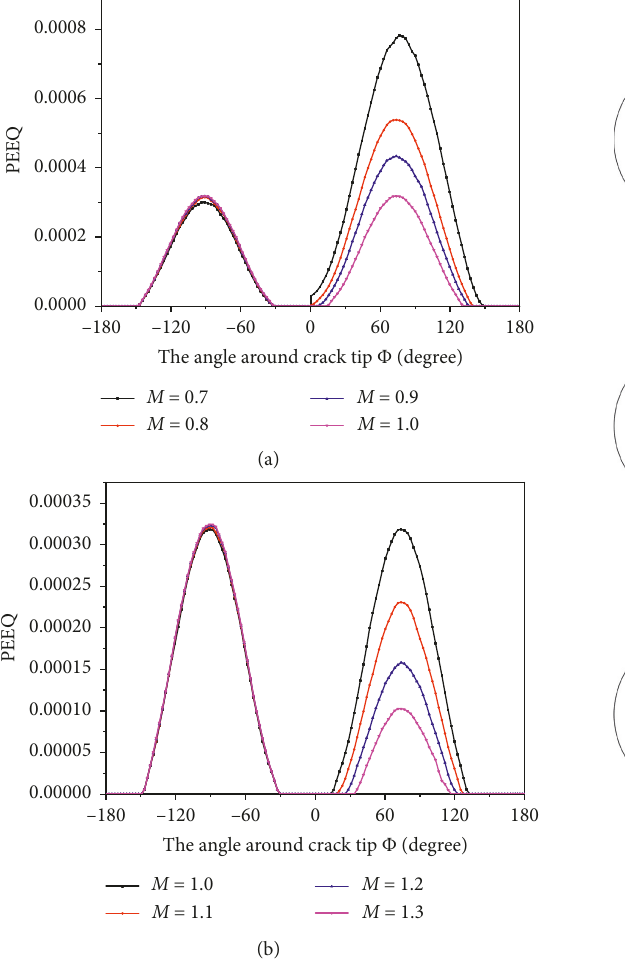
Figure 16: The equivalent plastic strain curve of “sandwich” material structure model around crack tip. (a) Mismatch coefficient M ≤ 1. (b) Mismatch coefficient M ≥ 1.